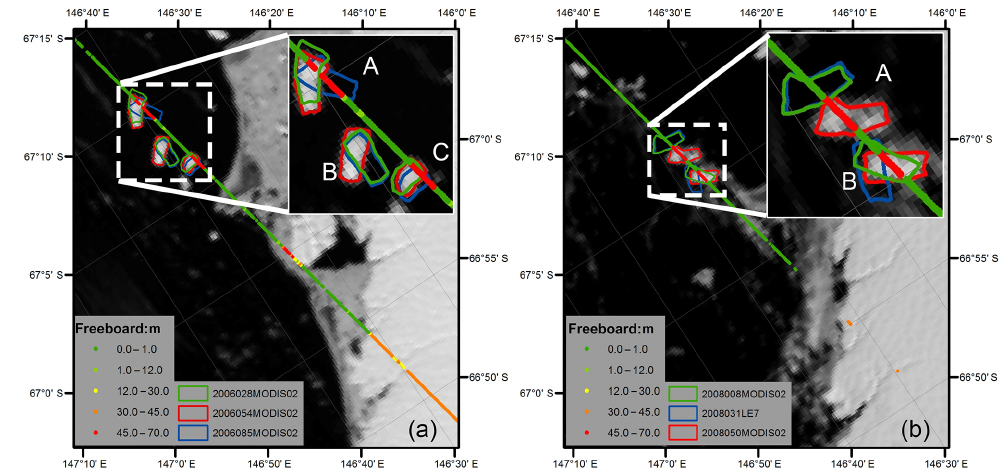
Figure 4. Freeboard extracted from Track T1289, ICESat/GLAS, the location of which can be found from Figs. 2 and 3b. ( a and b ) show the freeboard extracted from the ICESat/GLAS date from 23 February 2006 (2006054) and 18 February 2008 (2008049), respectively. In each image, the positions of three icebergs (with name labeled as A, B, and C) closest to the ICESat/GLAS observation date are plotted with green, red and blue polygons, respectively. The observation dates of remote sensing images are indicated with seven numbers (yyyyddd) in the legend. yyyyddd stands for day ddd in year yyyy. MODIS02 and LE7 indicate that the images used to extract outlines of the icebergs are from MODIS (Scambos et al., 1996) and Landsat 7 ETM + (USGS, 2016), respectively.